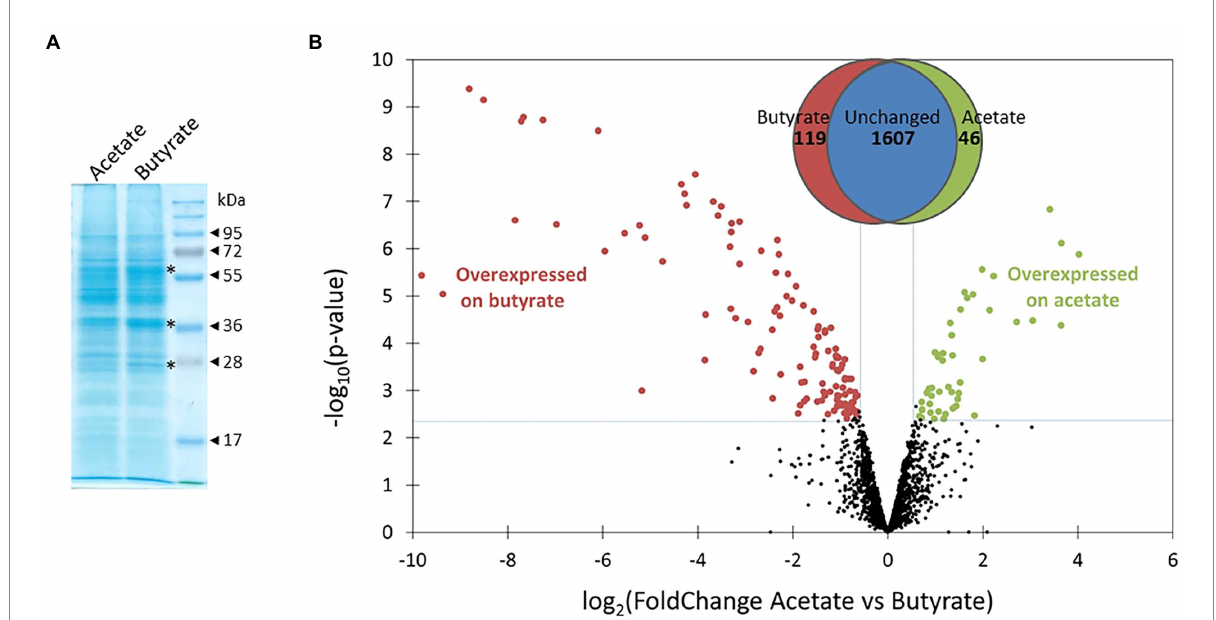
FIGURE 2 Comparison of global proteomes of Polytomella sp. grown on acetate and butyrate. (A) Total proteins (30 μ g) from exponentially growing cells, resolved in a 12% SDS-polyacrylamide gel stained with Coomassie Blue G250. (B) Volcano plot displaying the differential abundance of proteins of both conditions analysed by MS-based quantitative proteomics. The volcano plot represents the -log10 (limma value of p, cut off 0.004) on y -axis plotted against the log2 (FoldChange acetate/butyrate) on the x -axis. Green and red dots represent proteins more abundant in, respectively, the acetate or butyrate conditions (Benjamini-Hochberg FDR < 1%). The Venn diagram indicates that of the total of 1,772 proteins detected for acetate and butyrate combined, 46 were significantly induced on acetate and 119 on